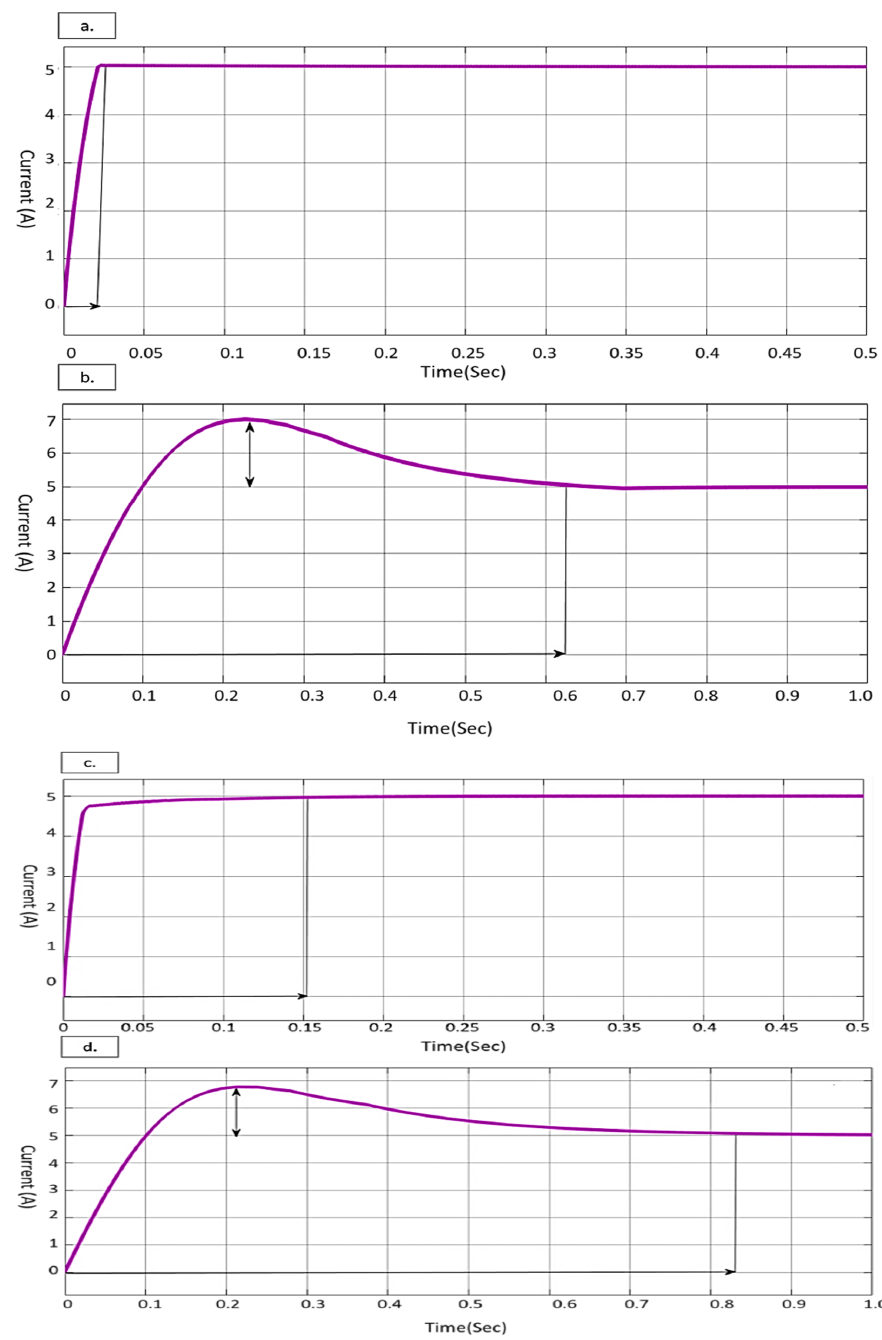
Figure 9. Simulation results during startup and tracking 5 A reference current: ( a ) FCC; ( b ) LCFF; ( c ) MBPS; ( d ) PI.